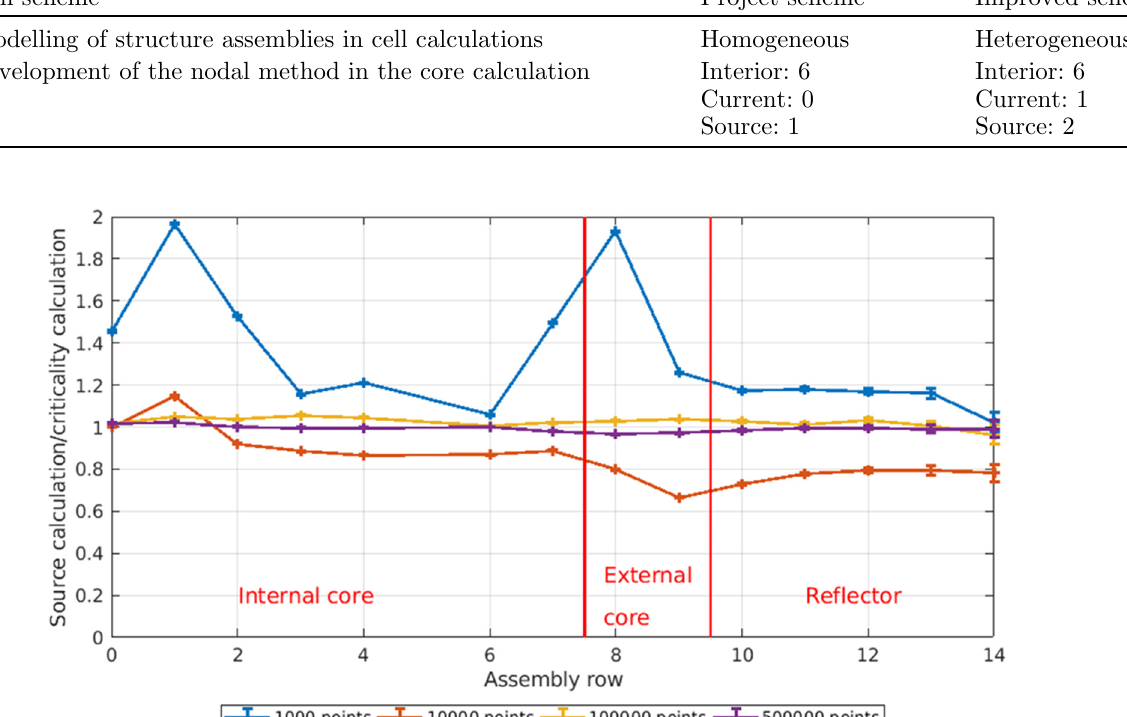
Fig. 6. Comparison between Monte Carlo shielding calculations using pointwise stochastic fi ssion sources and criticality